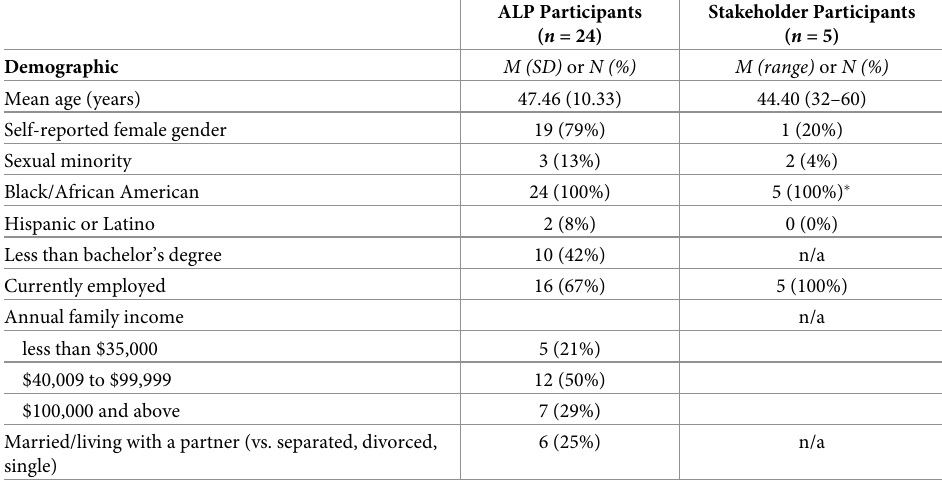
Table 2. Sociodemographic Characteristics of American Life Panel (ALP) participants and stakeholder partici- pants ( N = 29).